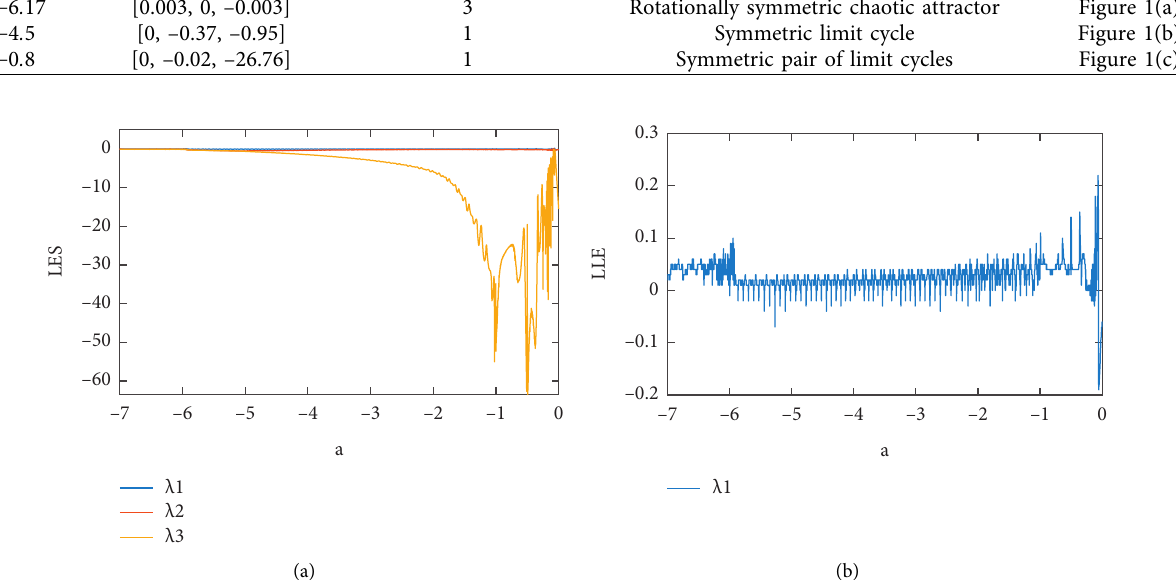
Figure 2: (a) Local finite-time Lyapunov exponents spectrum and (b) largest Lyapunov exponents of system (1) for b � − 1 ,c � 1 , e � 0, and a ∈ (− 7 , 0 ) .